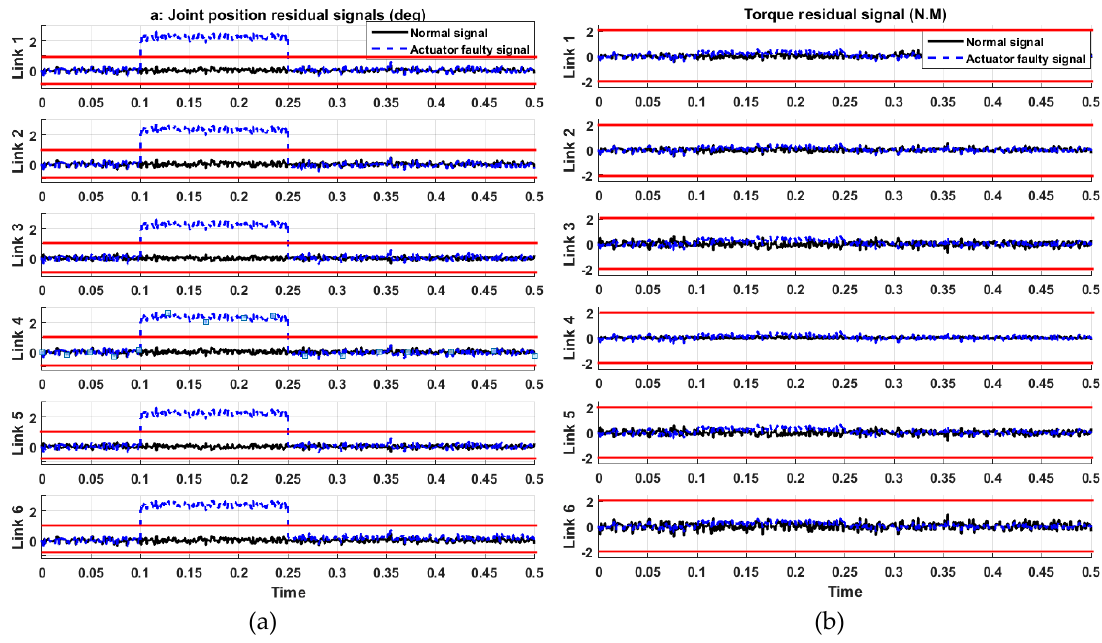
Figure 12. Residual signals in the faulty actuator condition: ( a ) Joint variable residual signals and ( b ) torque residual signals.